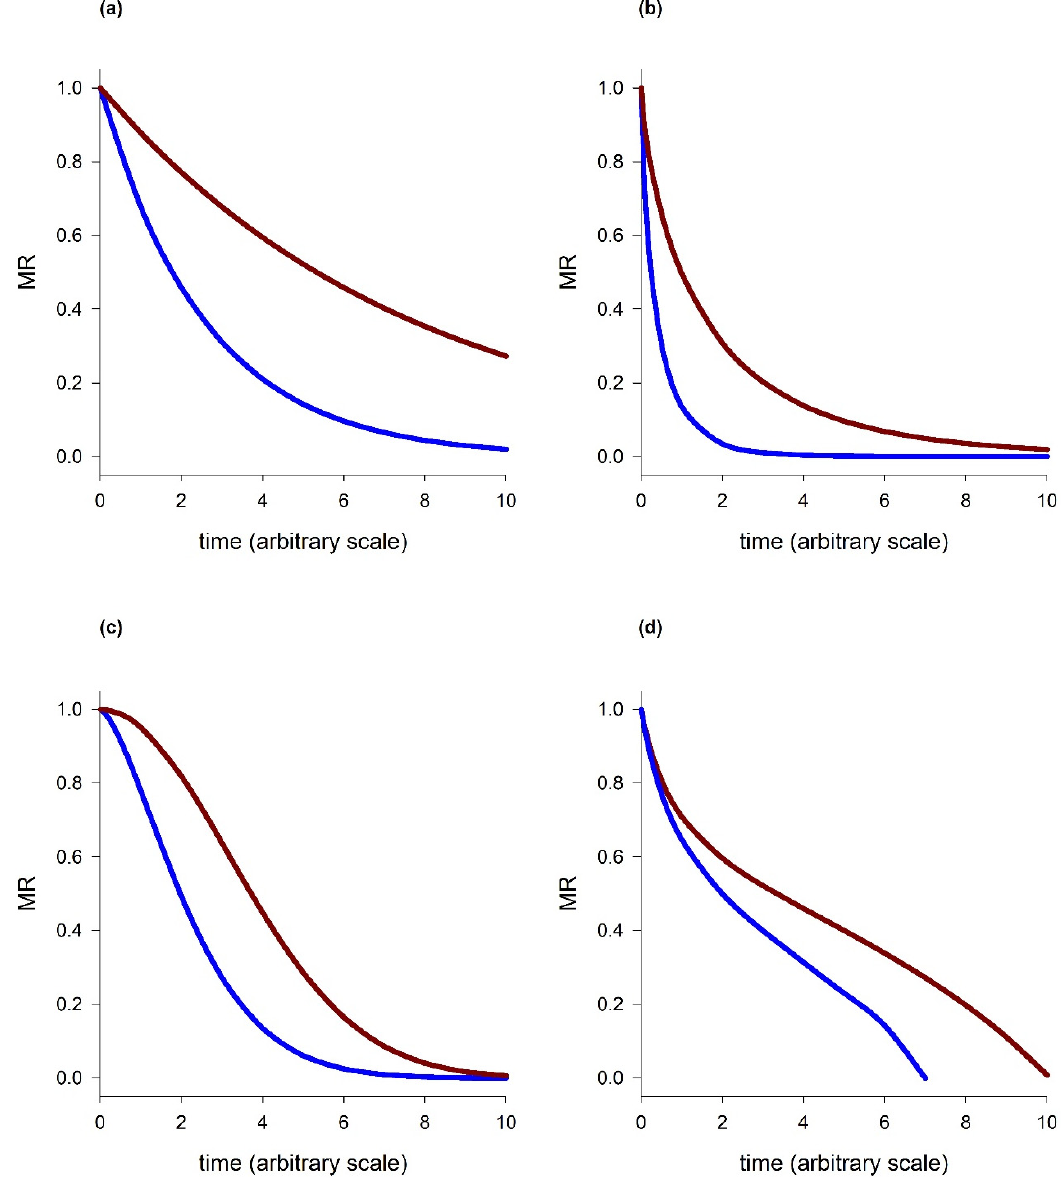
Figure 1. Simulated drying curves: concave or tailing ( a ), strong tailing ( b ), sigmoid-type I (convex followed by concave) ( c ) and sigmoid-type II (concave followed by convex) ( d ).